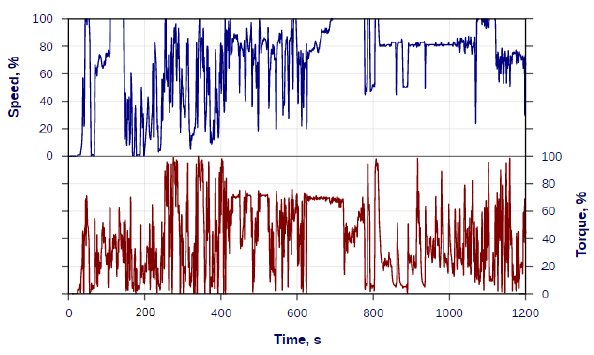
Fig. 2. Normalized speed and torque over NRTC cycle